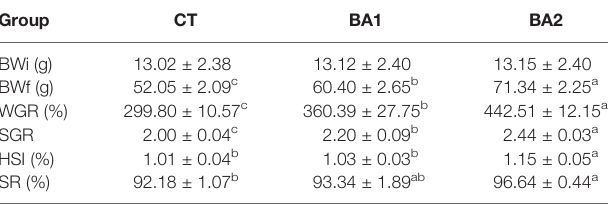
TABLE 3 | Growth performance, hepatosomatic index, and survival of tongue sole fed diets supplemented with bile acids for 10